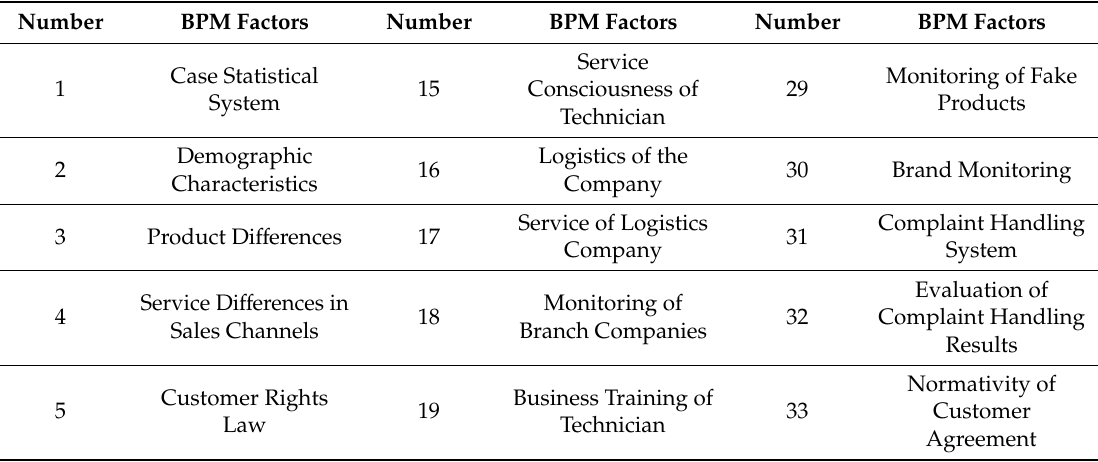
Table 2. Complaint handling process management